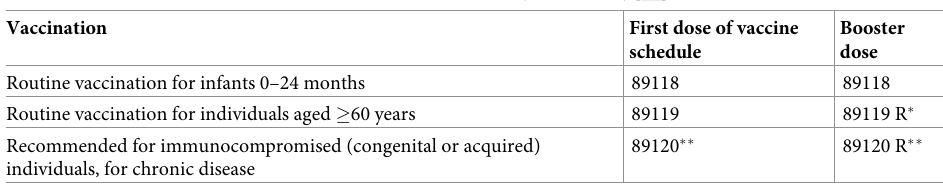
Table 1. Documentation codes for Pneumococcal vaccination (G-BA, 2020) [14].